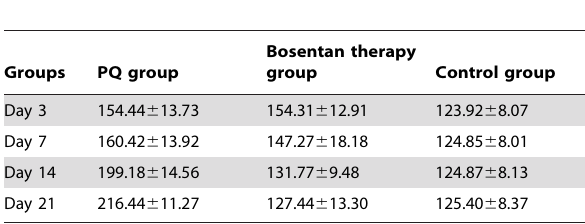
Table 4. Dynamic change of TGF- b 1 in the lungs of the three groups (mean 6 SD,